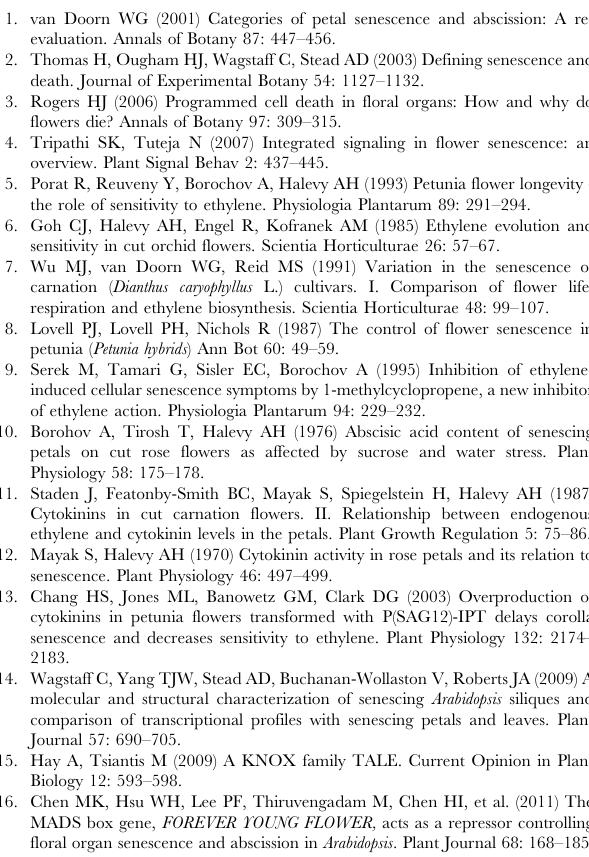
Figure S6 Effects of ethylene and 1-MCP on NCED